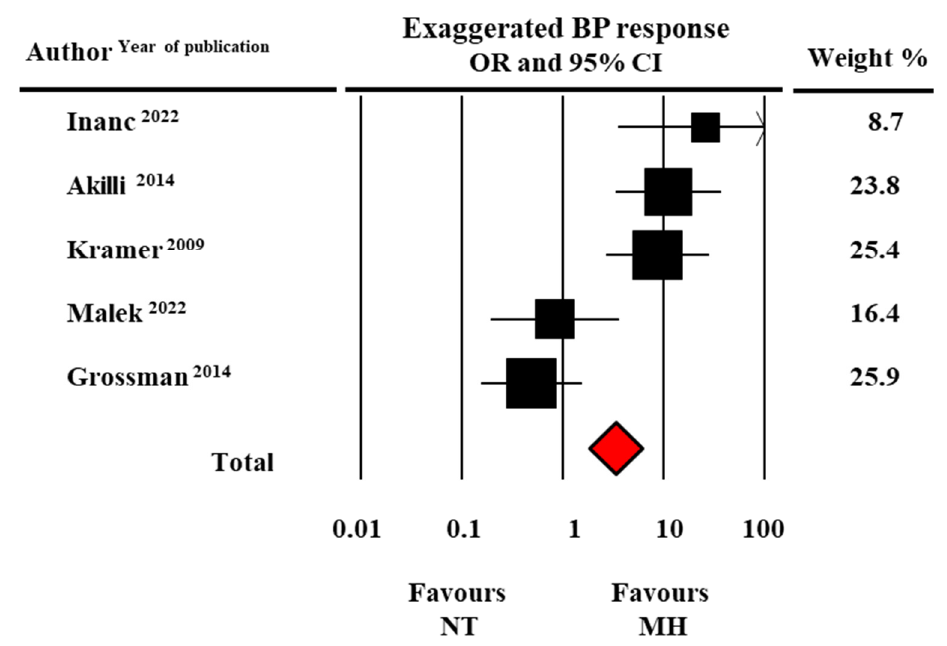
Figure 6. Forest plot of exaggerated systolic blood pressure (BP) to exercise in masked hypertensive (MH) and normotensive (NT) individuals. Odds ratio (OR) and 95% confidence interval (CI). Fixed model [21,24,25,28,29].